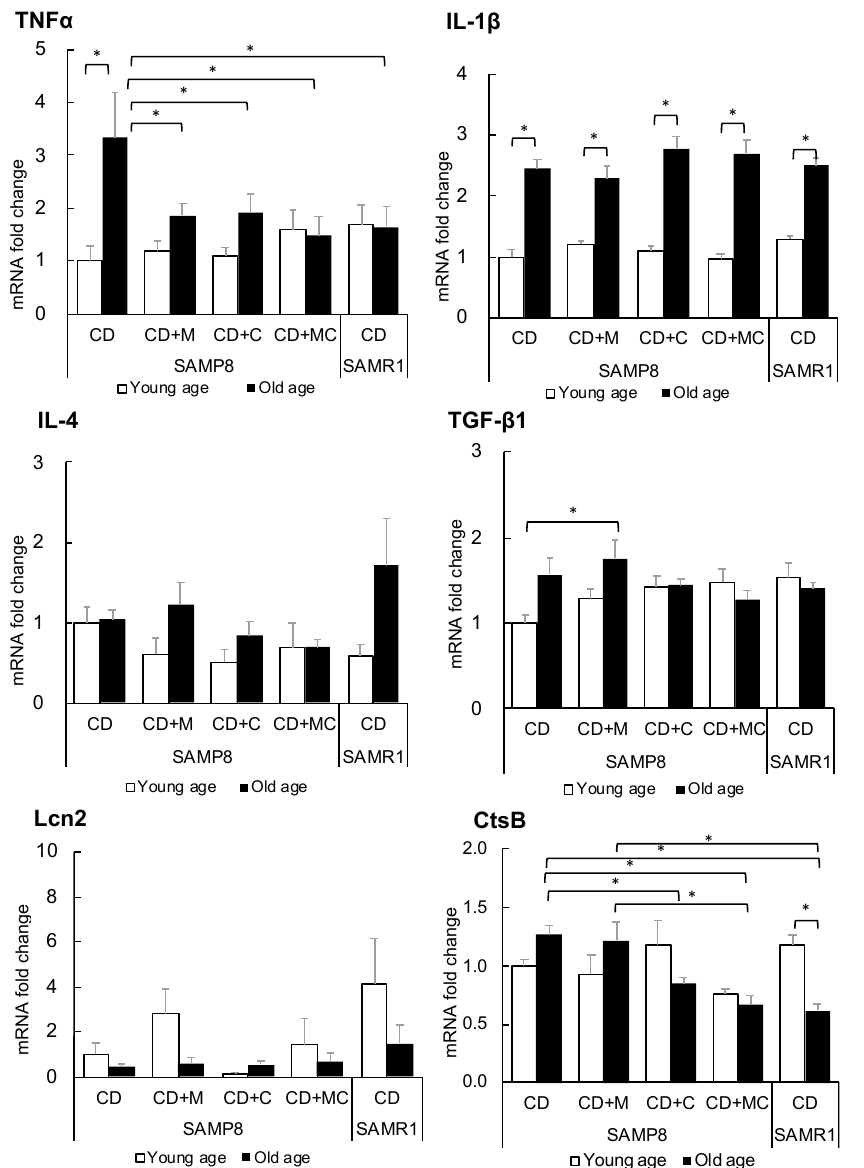
Figure 5. Changes in the expression of inflammatory genes in the cerebral cortex. Each value represents the mean ± SEM ( n = 6). Asterisks denote significant differences (*, p < 0.05, Fisher’s least significant difference test).